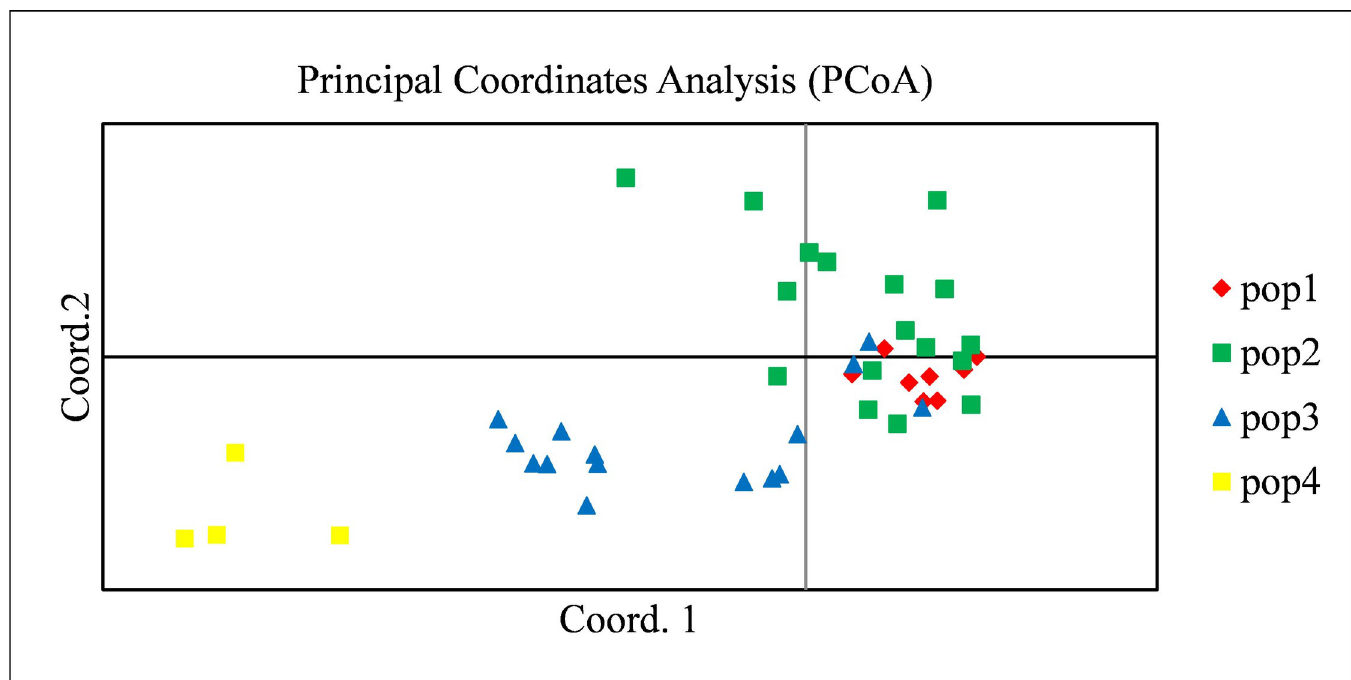
Fig 4. Principal Coordinate Analysis (PCoA) of 44 pigeonpea genotypes based on the population structure result.